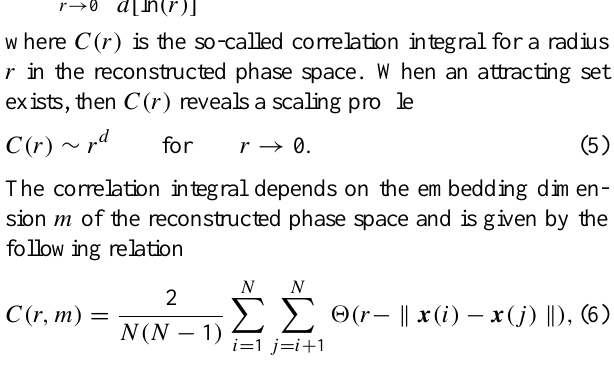
Fig. 3. (a) The autocorrelation coefficients of the deterministic x(t) Lorenz signal, of the stochastic x(t) Lorenz signal and its V 1 SVD component corresponding to the levels e = 0 . 1 (37%) and e = 0 . 5 (185%) of the external additive coloured noise perturbation. (b) The autocorrelation coefficients of the V 2 − 15 SVD component of the stochastic x(t) Lorenz signal corresponding to the two levels e = 0 . 1 (37%) and e = 0 . 5 (185%) of the external additive coloured noise perturbation. (c) The same with Fig. 3b but for the V 4 SVD